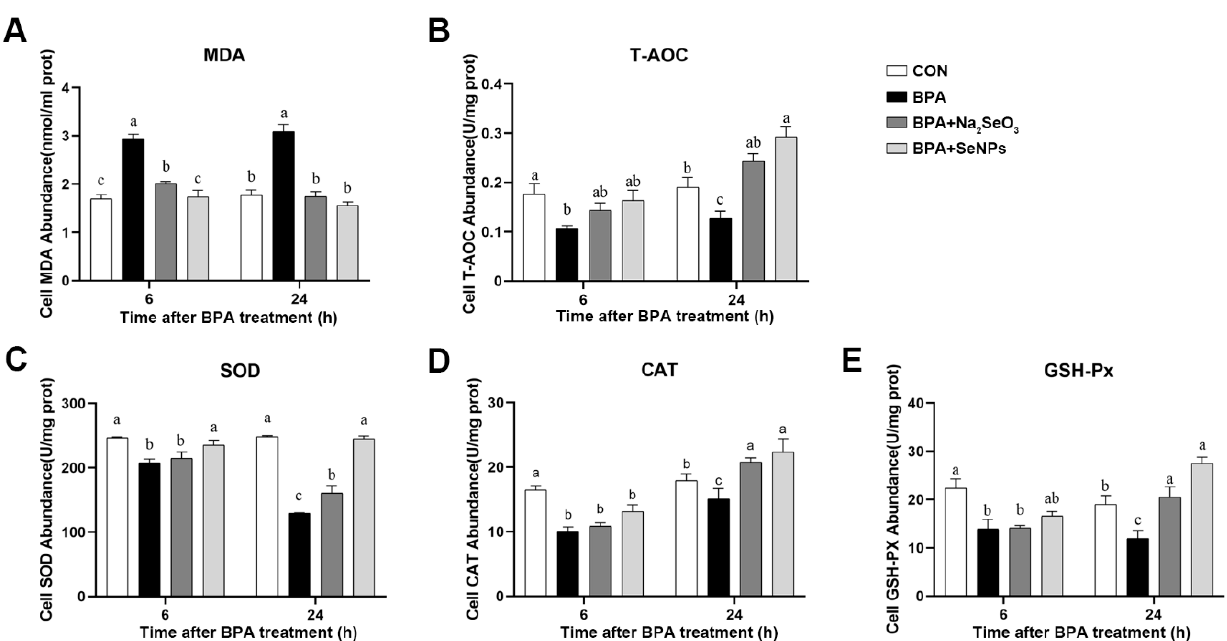
Figure 6. Effects of Na 2 SeO 3 and SeNPs treatment on oxidative stress of IPEC-J2 cells after BPA exposure. Oxidative stress was analyzed by measuring the level of MDA ( A ), T-AOC ( B ), SOD ( C ), CAT ( D ), and GSH-Px ( E ). Data are presented as the means ± SEM of three independent experiments. a,b,c, Mean values within a row with different superscript letters were significantly different ( p < 0.05). 2.7. SeNPs Ameliorated the BPA-Induced ERS in IPEC-J2